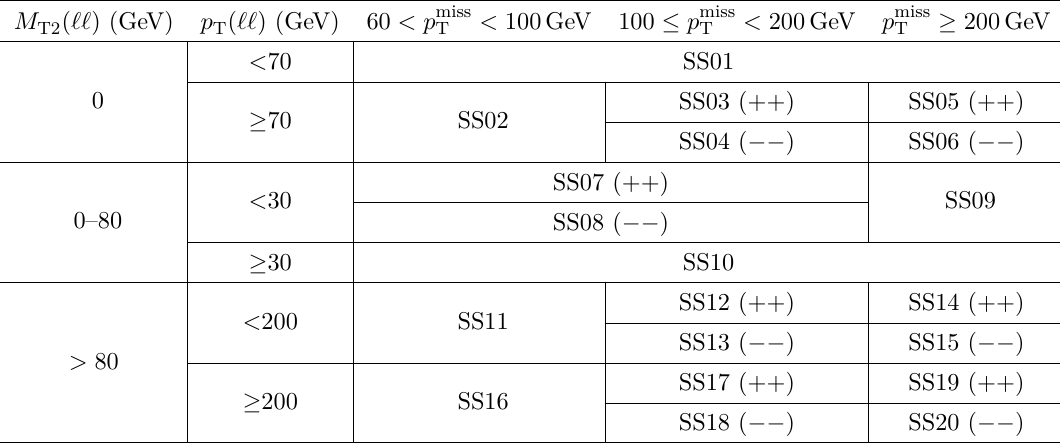
Table 2 . Definition of the search regions used for events with two same-sign light leptons (SSXX). The symbols ( ++ ) and ( −− ) represent requirements on the sign of the leptons. The first M bin contains only events where M ( ‘‘ ) is exactly 0 [68], whereas the second bin contains events T2 where M ( ‘‘ ) is larger than 0 and less than or equal to 80 GeV. The last M T2 events where M ( ‘‘ ) exceeds 80 T2